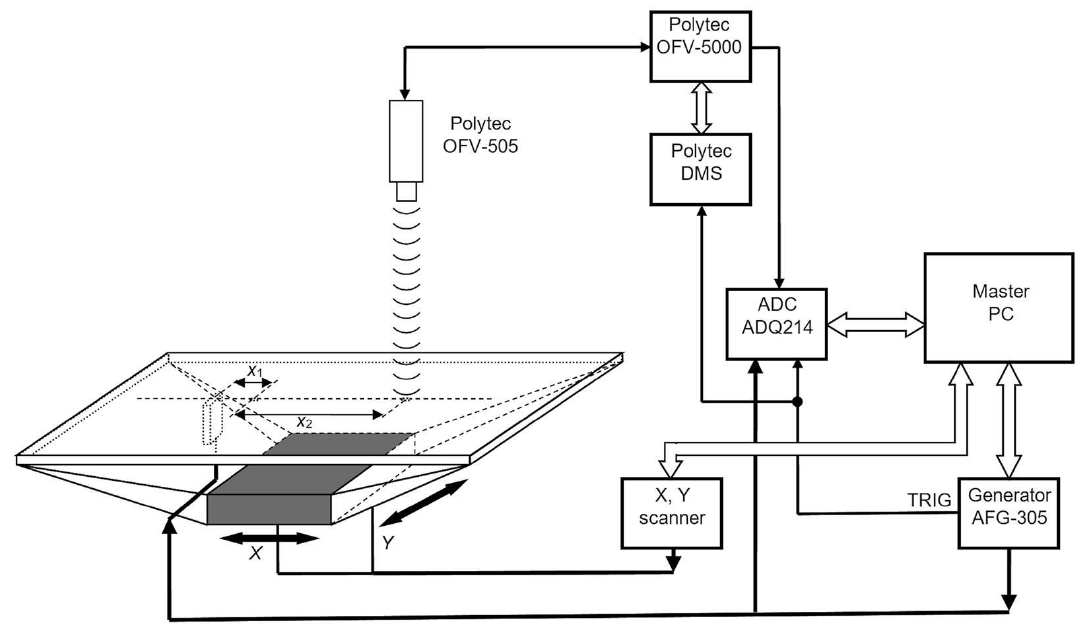
Figure 8. The experimental set-up for the measurement of A 0 mode Lamb wave attenuation in a PVC film.